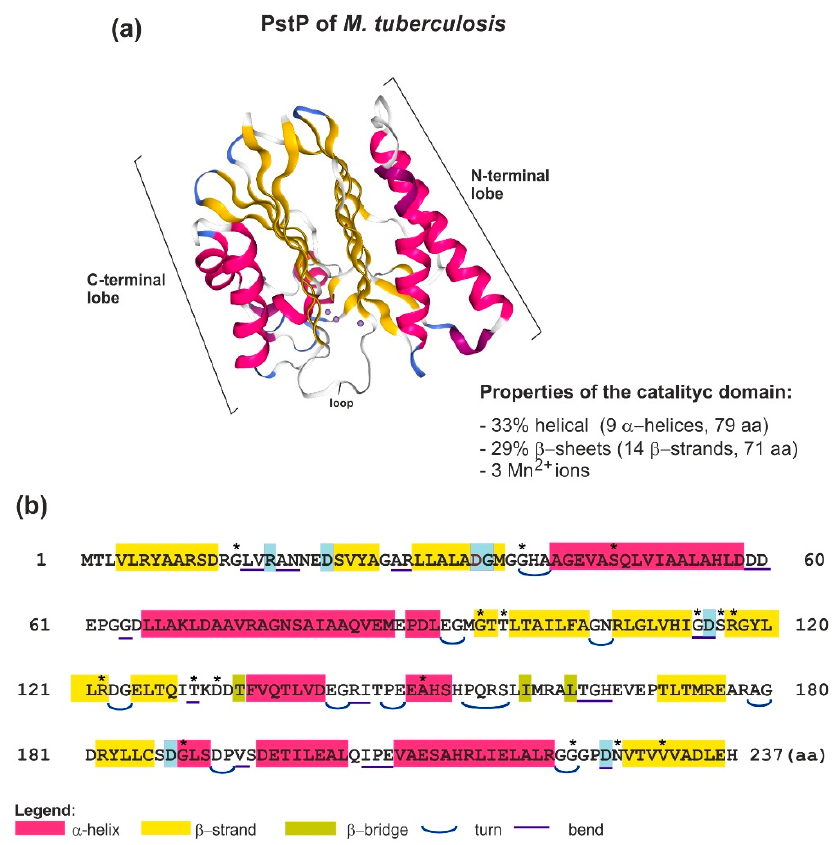
Figure 2. Structure of the catalytic domain of M. tuberculosis STP PstP. ( a ) Crystal structure of the PstP catalytic domain with Mn 2+ ions (PDB accession number 1TXO) [178]. The β -sandwich is represented in yellow, α -helices are represented in pink, and Mn 2+ ions are shown as purple spheres. N-terminal and C-terminal lobes and the large irregular loop are indicated. ( b ) Primary amino acid sequence of the 237-residue catalytic domain of PstP. Conserved amino acids are denoted by asterisks, and those forming a part of the metal-binding pocket are shaded in blue.